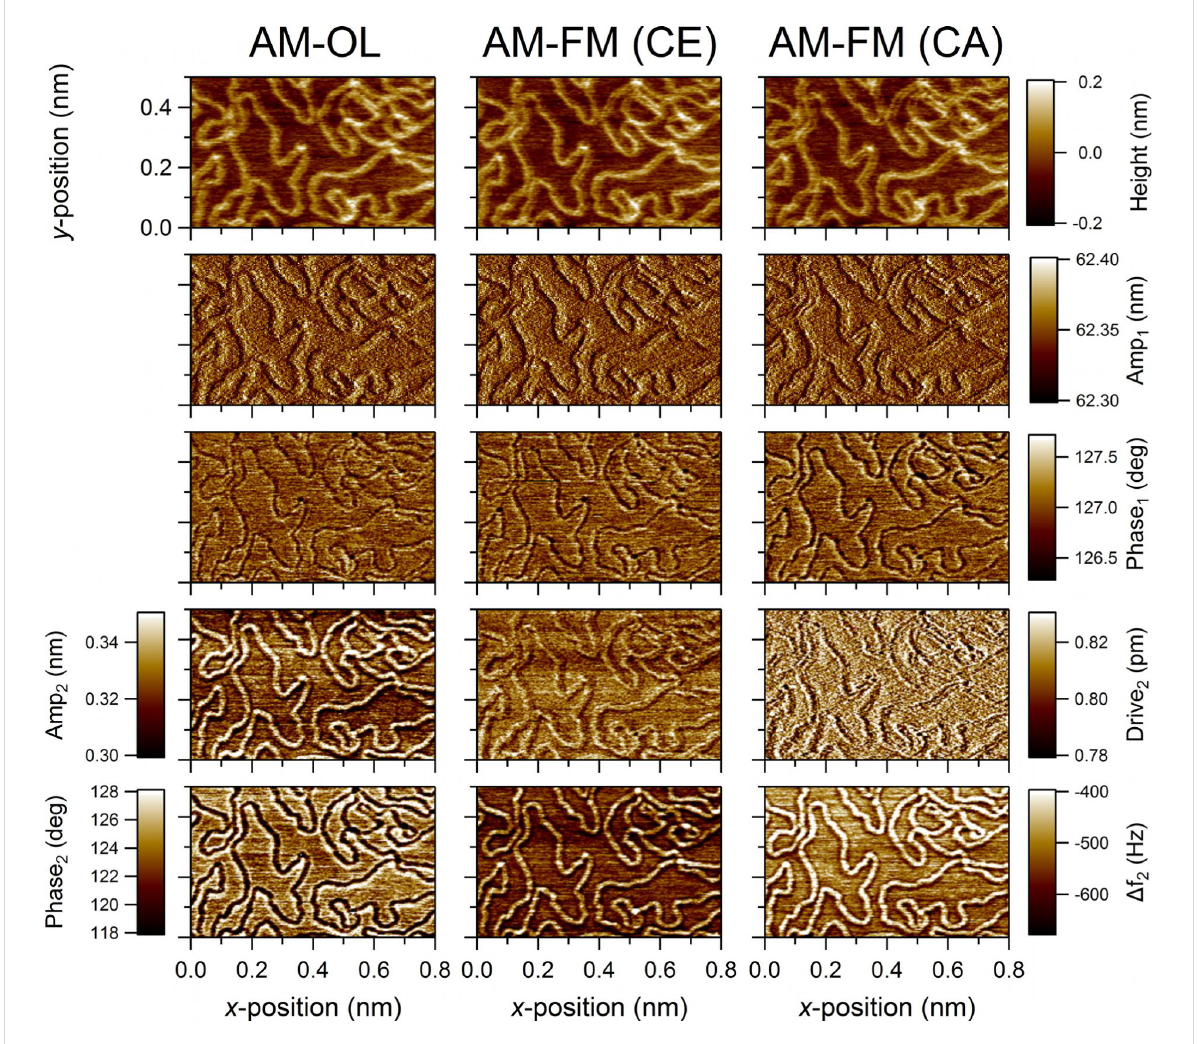
Figure 4: 500 × 800 nm 2 sized images of DNA/mica samples in three different multifrequency AFM modes (AM-OL, AM-FM (CE), AM-FM (CA)). Data channels in rows from top to bottom show: height, 1st amplitude, 1st phase shift, 2nd amplitude (oscillation or drive), 2nd phase or frequency shift (see Figure 3 for